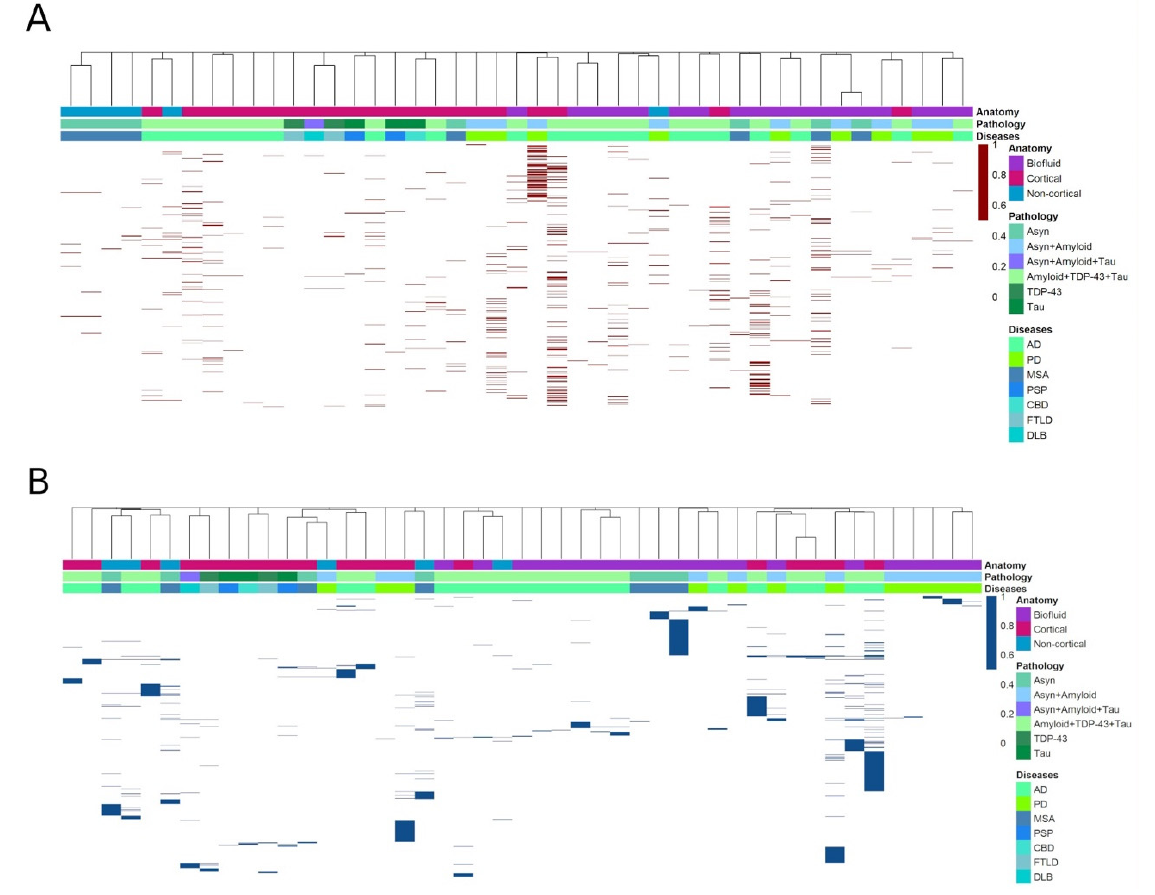
Figure 2. Distribution of upregulated (red) ( A ) and downregulated (blue) ( B ) miRNAs. N = 45 (up- regulated) and 47 (downregulated) expression profiles. The X-axis in each heatmap corresponds to a miRNA profile, while the Y -axis corresponds to individual miRNAs differentially expressed. The heatmap classifies profiles on the basis of miRNA differential expression in a specific disease, pathology or anatomy. The heatmap demonstrated minimal clustering as per these specified criteria. A greater number of upregulated miRNAs were repeatedly expressed. The distance between profiles was calculated using the asymmetric binary similarity measure.